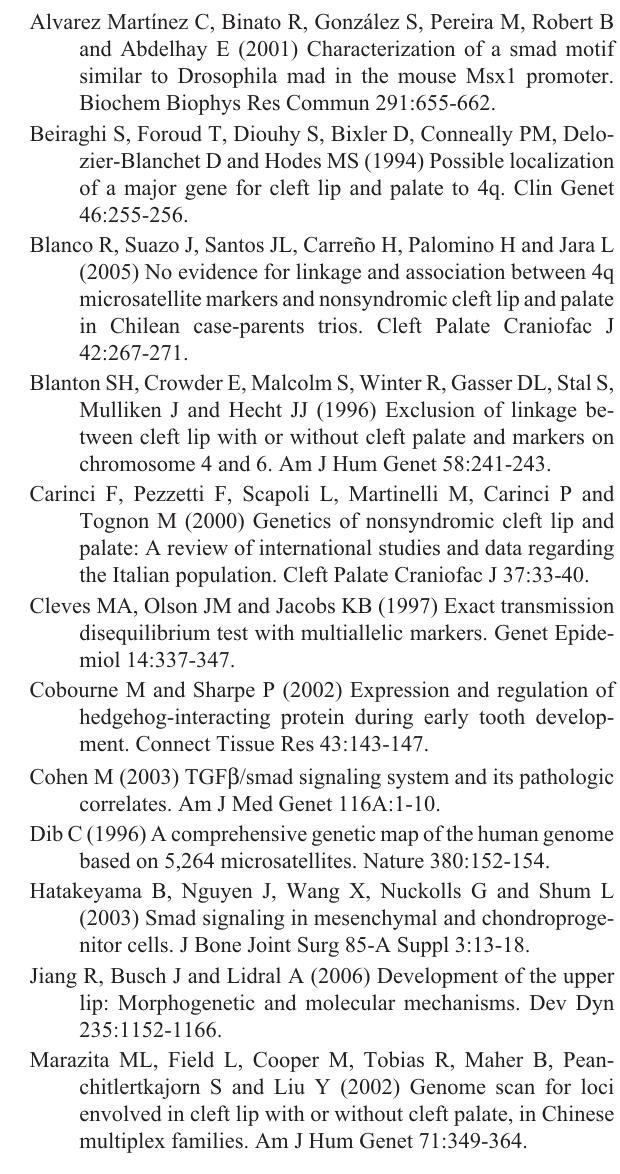
Table1 -TransmissionDisequilibriumTest(TDT)analysisfortheassoci- ation between the D4S1586 marker and nonsyndromic cleft lip/palate (NSCLP) in 58 case-parents triads.